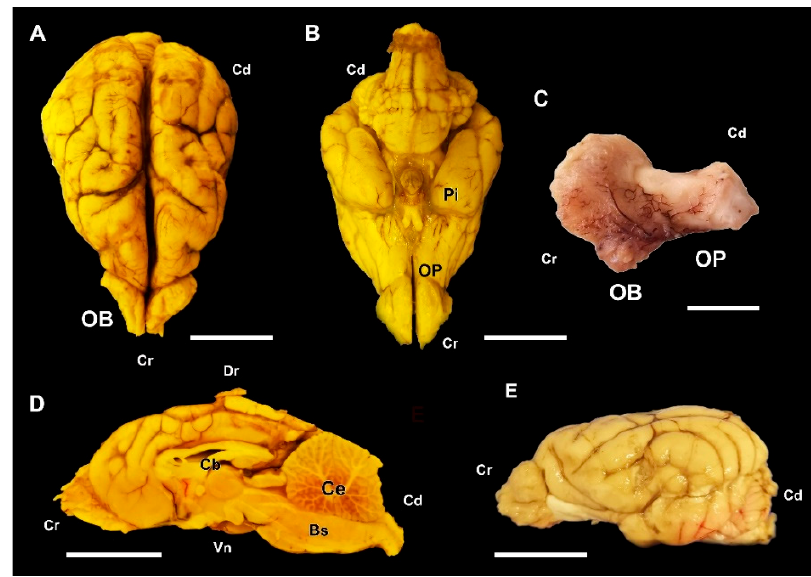
Figure 17. Macroscopic anatomy of the olfactory bulb (OB) of the fox. ( A , B ) Dorsal and ventral view of the encephalon, respectively. ( C ) Medial view of the right OB after removing the frontal lobe. ( D ) Medial view of the right hemiencephalon. ( E ) Lateral view of the encephalon. Bs, Brainstem; Cb, Callosal body; Ce, Cerebellum; OP, olfactory peduncle; Pi, Piriform lobe. Position terms: Cr, Cranial; Cd, Caudal; Dr, dorsal; Vn, Ventral. ( A , B , D ): Bouin’s liquid fixation. ( C , E ): Formalin fixation. Scale bars: ( A , B , D , E ): 2 cm; ( C ): 0.5 cm.